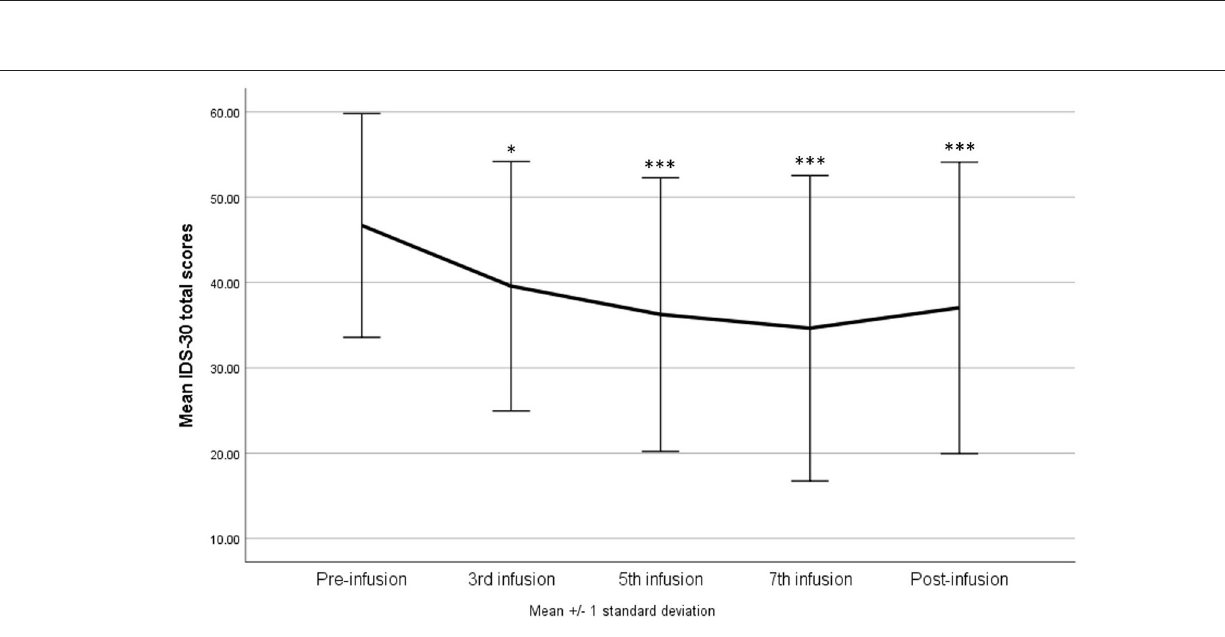
a significant decrease in the intensity of suicidal ideation reflected in the score of item 18 after the fifth and the seventh infusions. The indirect effect of anhedonia on the severity of the depression was investigated in a mediation model, which confirmed that reduction in depressive symptoms was mediated by the antianhedonic effect, meaning that the